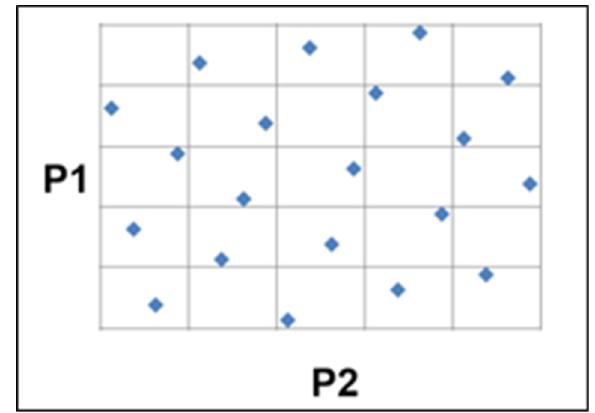
Figure 14. Optimal space filling design (OSF) [31]. Different design points are generated using the optimal space filling design scheme. These points are shown in column B, C and D of Table 4. The output parameters, i.e., equivalent stress (column E), total deformation (F) and solid mass (G) are evaluated for each design point. Table 4. DOE table for optimal space filling (OSFF) design.